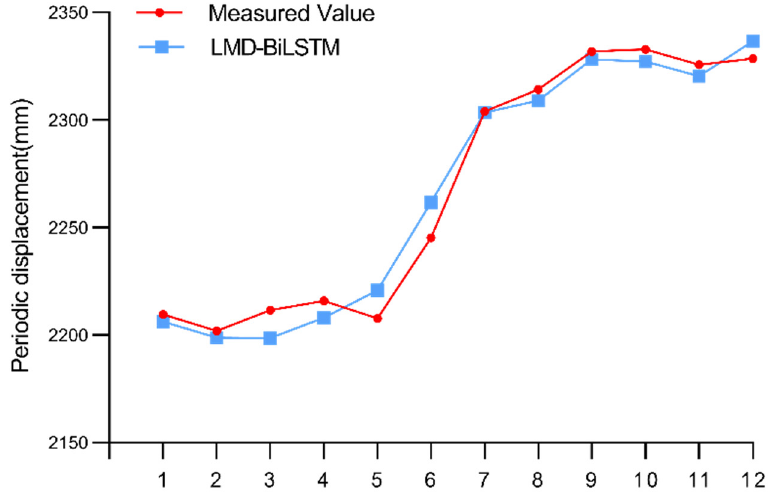
Figure 8. Final prediction results of landslide displacement.